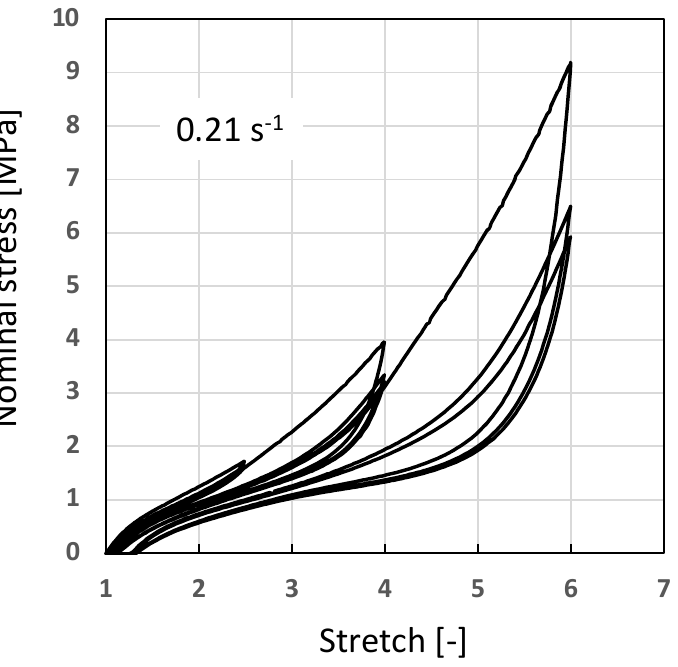
0.21 s − 1 , extracted from ±